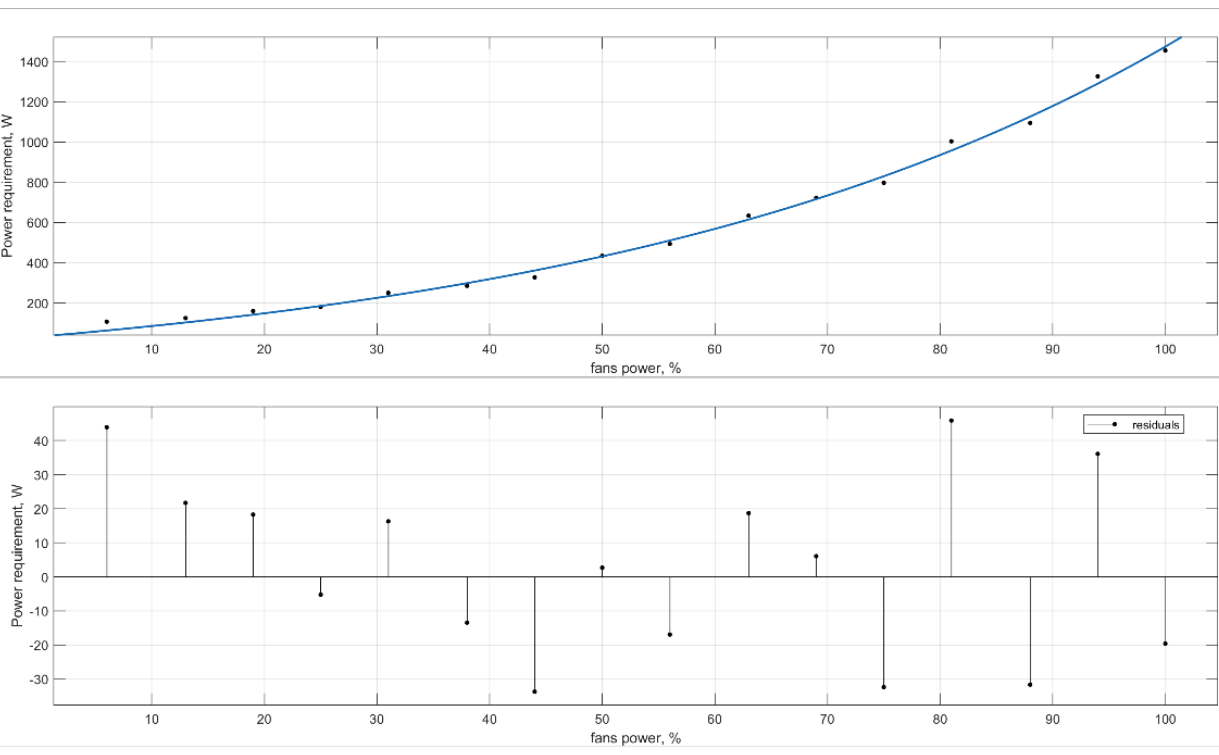
Fig. 17. Observed parameters of power requirement, W, with respect to fan load, %, in field